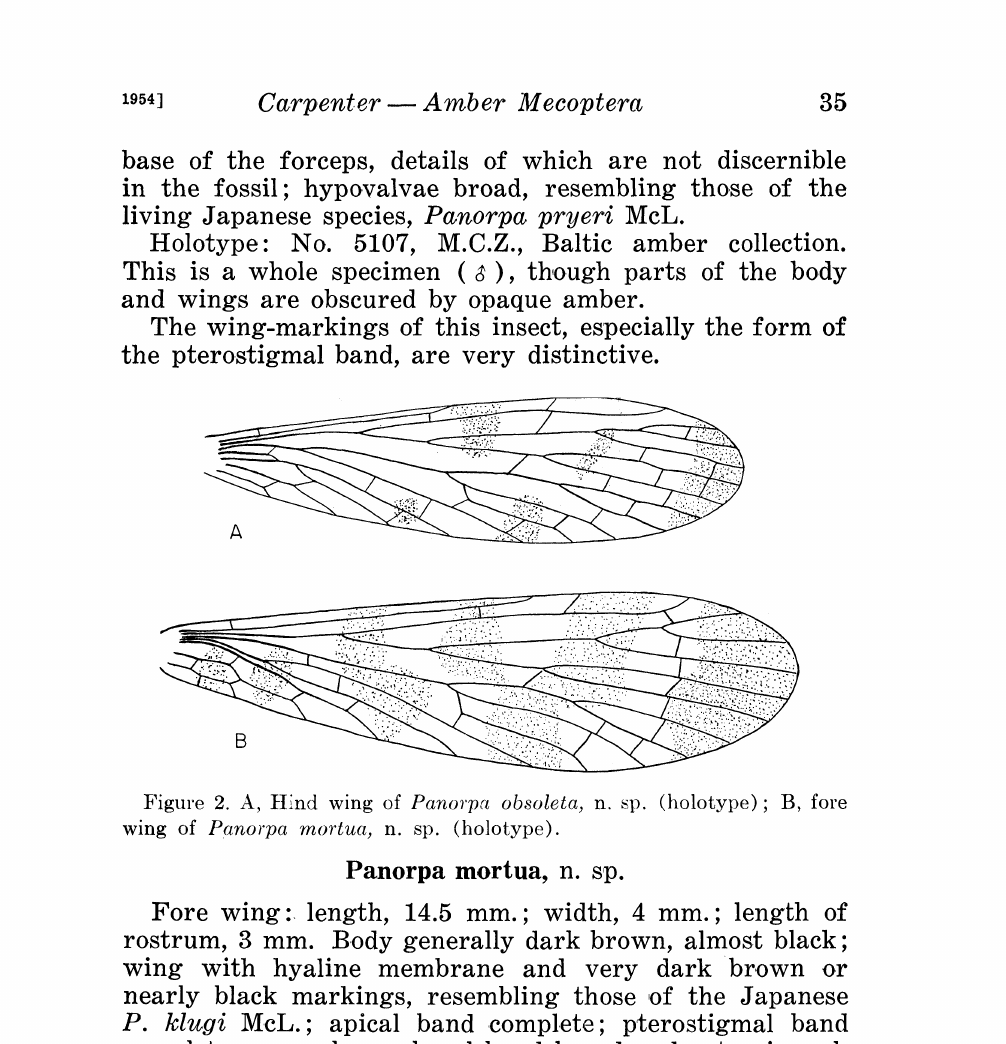
Figure 2. A, Hind wing of Panorpa obsoleta, n. sp. (holotype) B, fore wing of Panorpa mortua, n. sp.